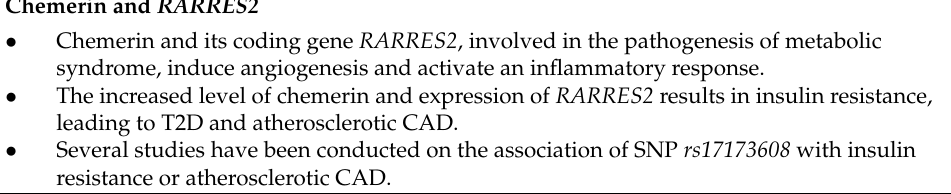
Table A1. Summary